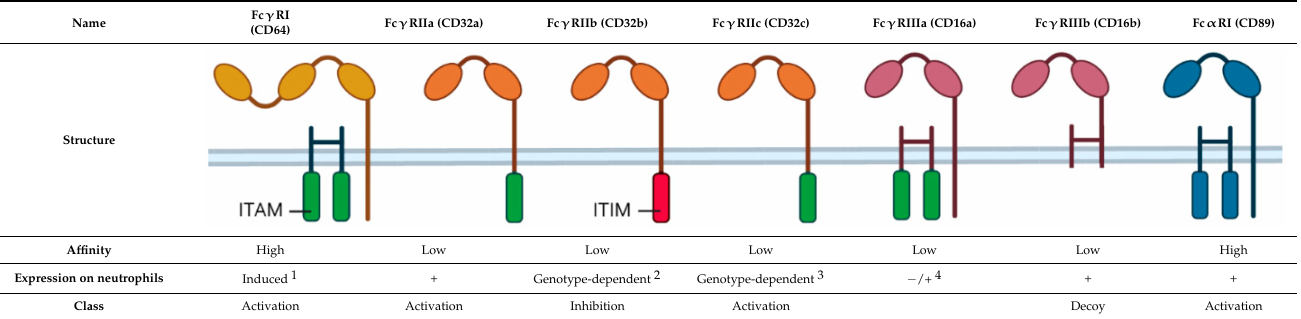
Table 1. Fc receptors expressed on